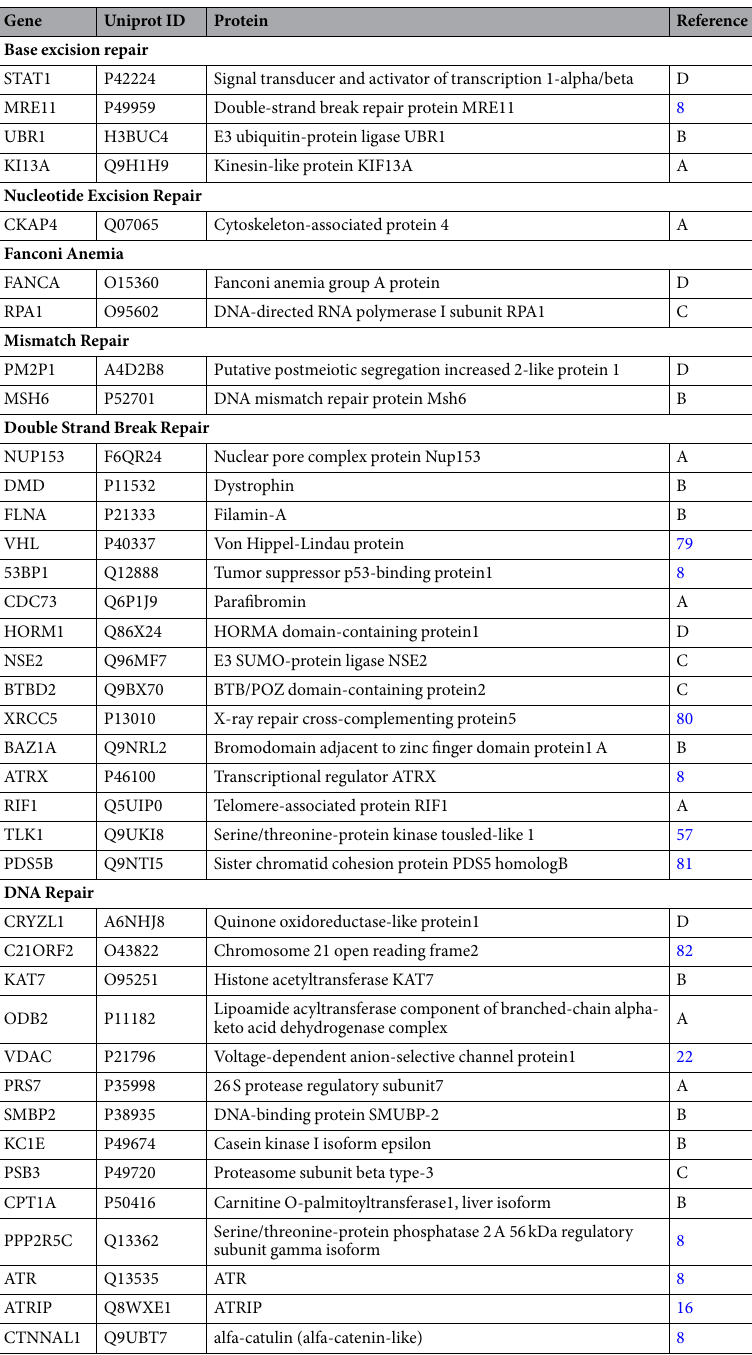
Table 2. Human NEK1-Interacting Proteins related to DNA damage response. A- NEK1 IP-LC-MS/MS; B- NEK1 IP-LC-MS/MS + cisplatin; C- phosphoproteome in NEK1 IP-LC-MS/MS; D- phosphoproteome in NEK1 IP-LC-MS/MS +